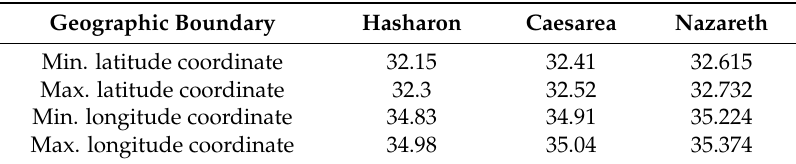
Table A2. The suburban regions analyzed [13].